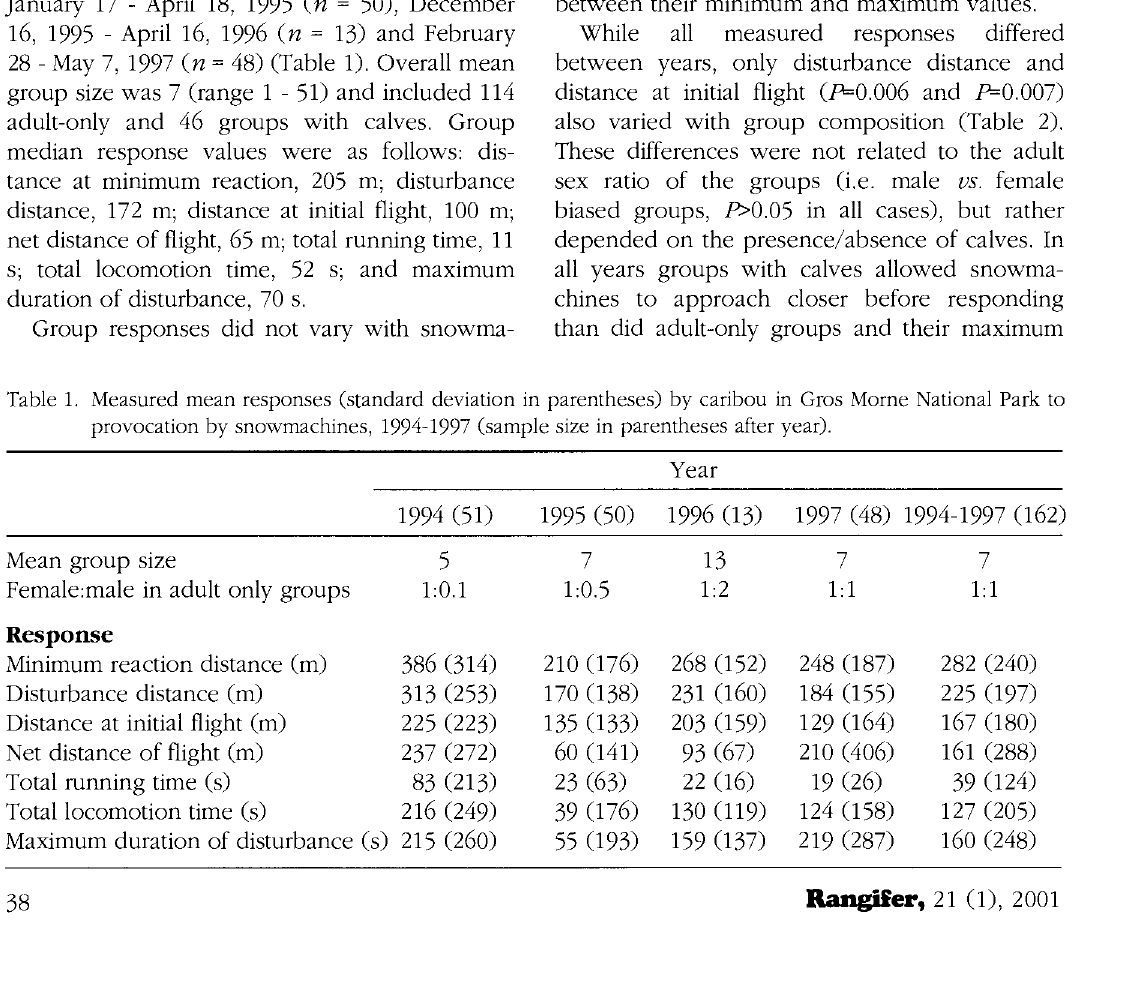
Table 1. Measured mean responses (standard deviation in parentheses) by caribou in Gros Morne National Park to provocation by snowmachines, 1994-1997 (sample size in parentheses after